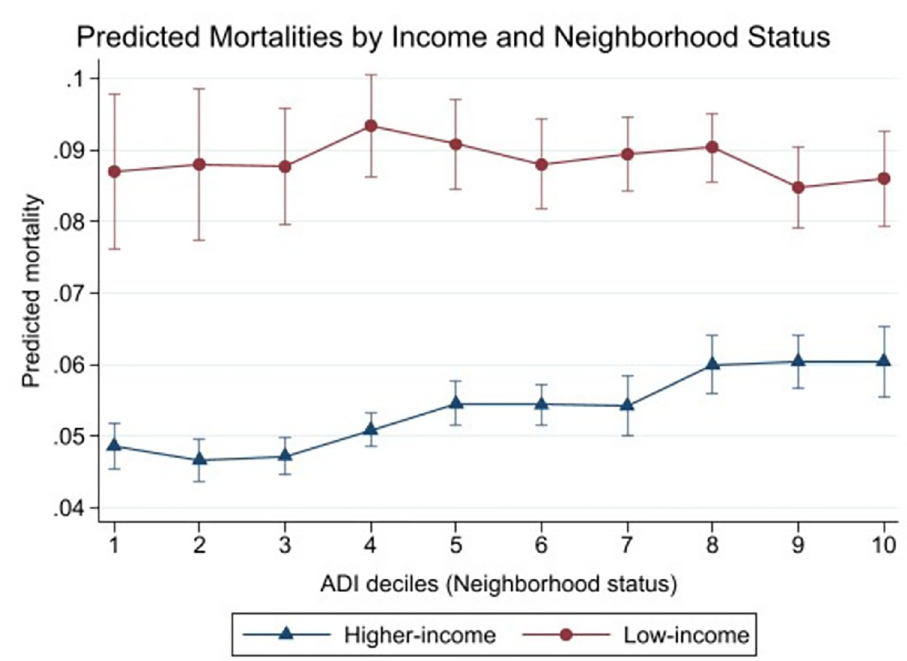
Fig 1. Predicted mortality rates by ADI decile groups, higher-income vs. low-income among older adults ages 65 +. Source: Medicare Health Outcomes Survey, 2014–2015. Note: The predicted mortalities were obtained based on the regression models presented in Table 2. The models were controlled for age (65–69, 70–74, 80–84, 85 or older), sex (male, female), race/ethnicity (non-Hispanic white, non-Hispanic Black, non-Hispanic Asian, Hispanic, other), the number of chronic conditions (none, 1–2, 3–5, 6 or more), BMI (normal/overweight, obese, underweight), difficulties in ADL (none, 1 or more), smoking status (not smoking, smoking), and survey year (2014, 2015).